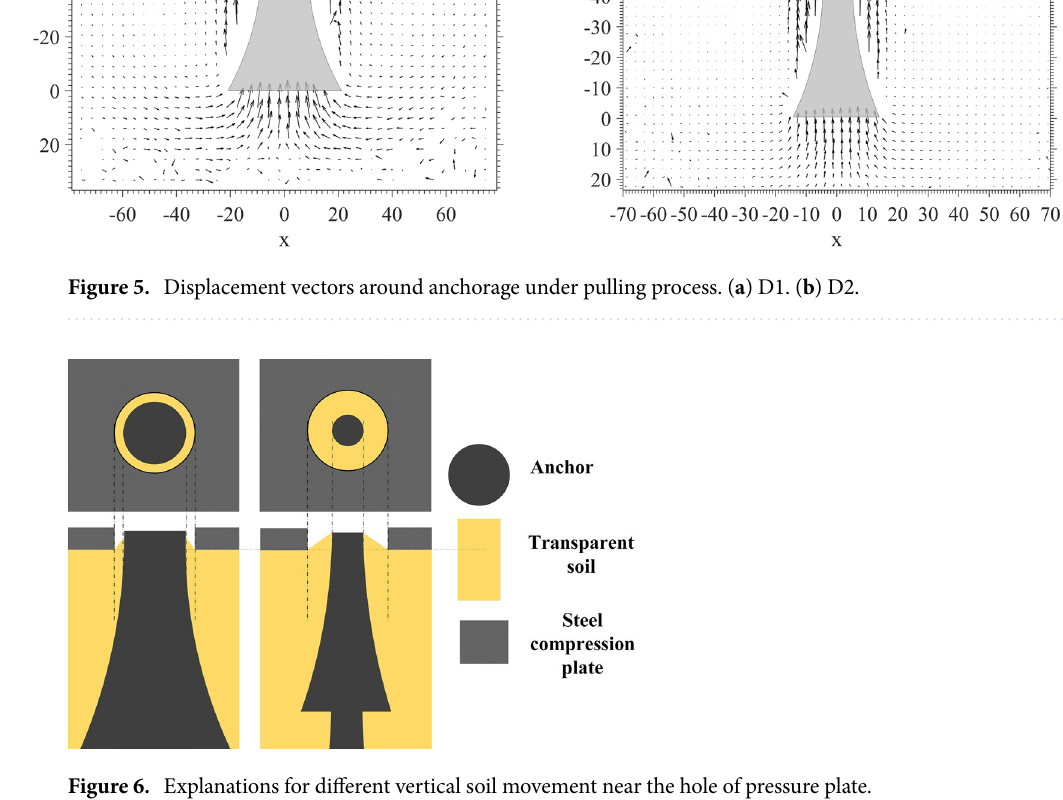
Figure 6. Explanations for different vertical soil movement near the hole of pressure